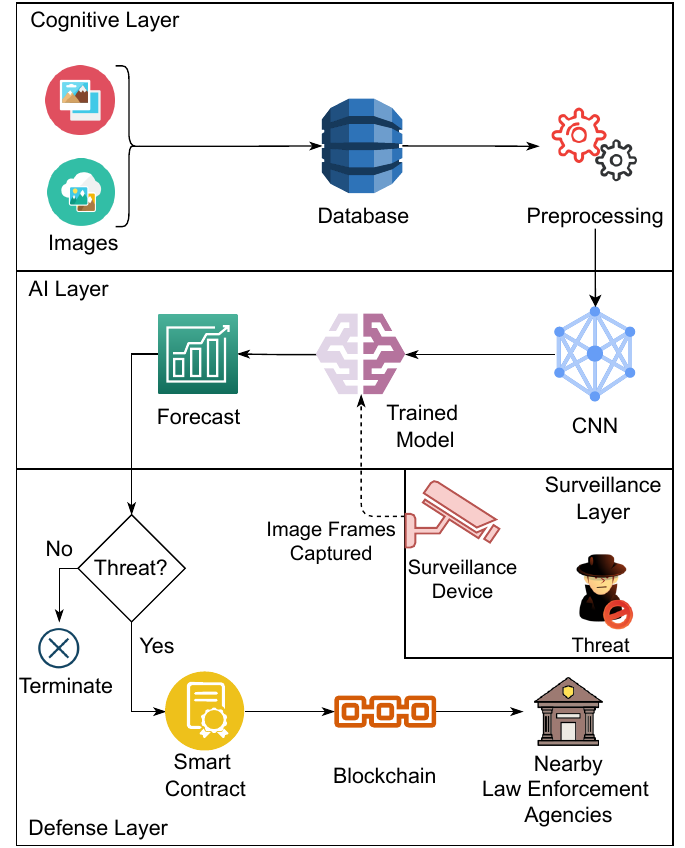
Figure 3. The proposed BlockCrime